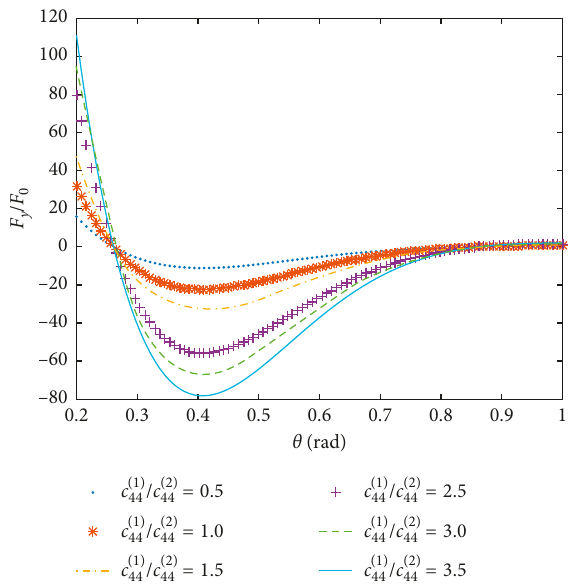
Figure 9: Relationship between image force F different values of the parameter c ( 1 )